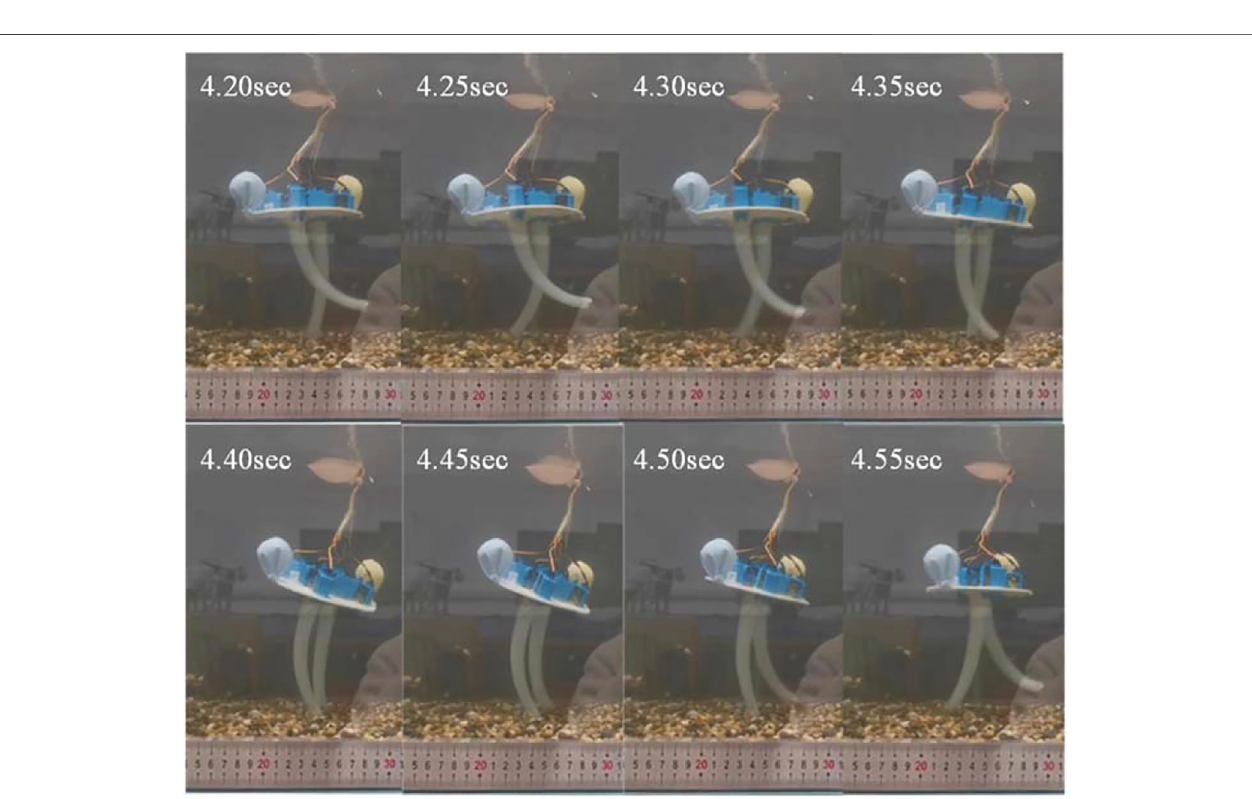
FIGURE 17 | Frame-by-frame analysis of the video of the straight walking on the sandy ground.